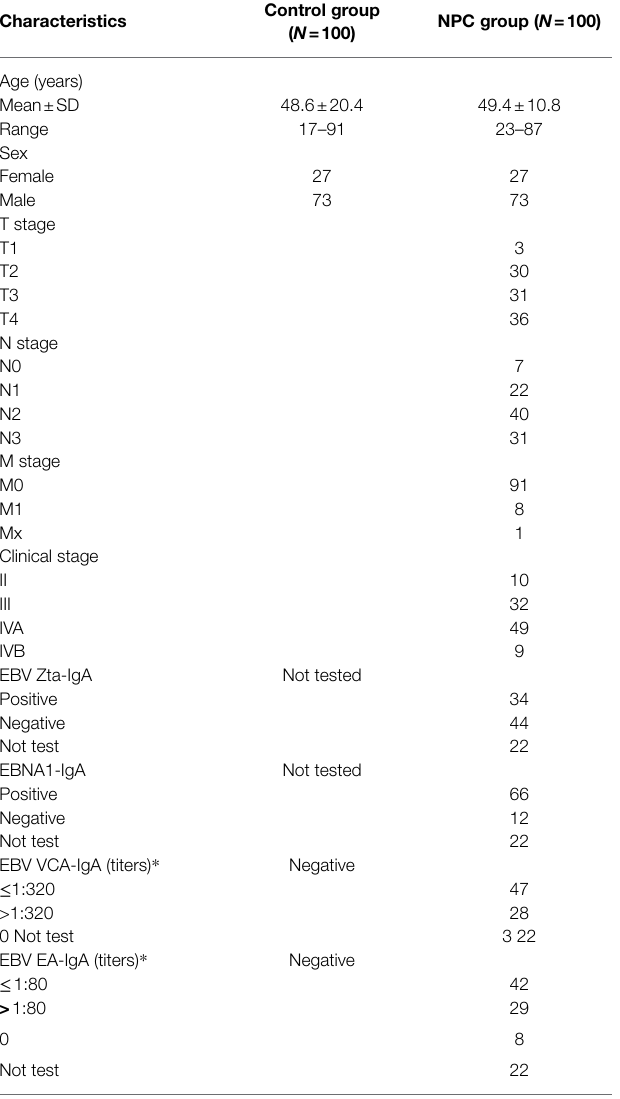
TABLE 1 | Characteristics of nasopharyngeal carcinoma (NPC) patients and their age- and sex-matched healthy controls. Characteristics